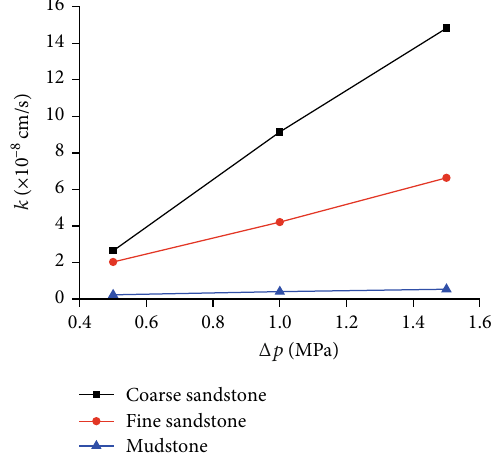
Figure 21: Comparison of three permeability coe ffi cients ( σ =2MPa, Δ p